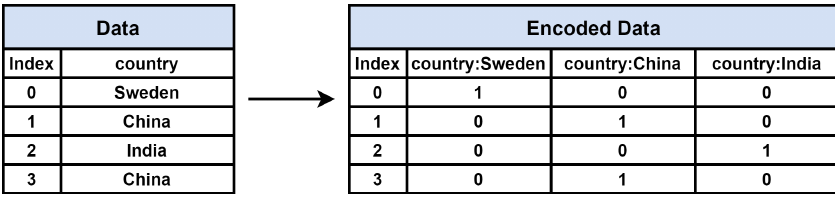
Figure 4. Example of using one-hot